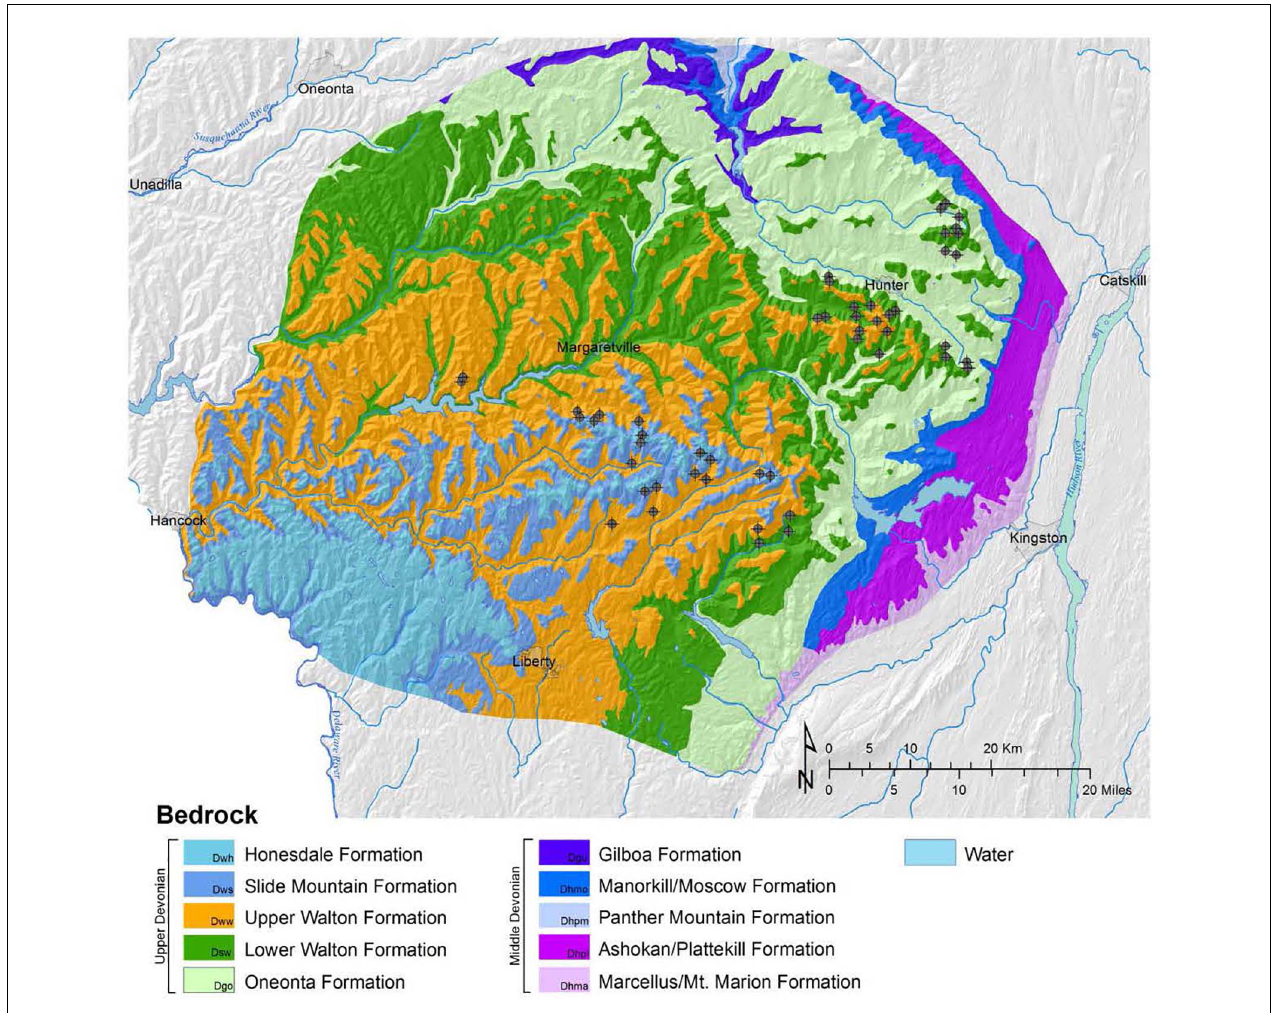
FIGURE 2 | Locations of the study watersheds superimposed on a map of bedrock geology. Bedrock geology layer taken from Ver Straeten